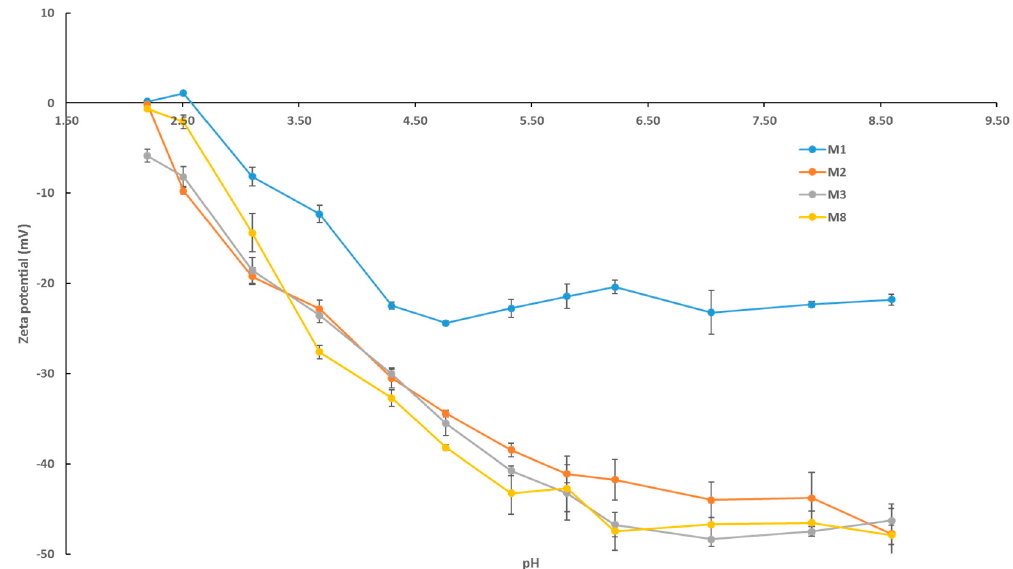
Figure 7 . pH scans for selected fabricated PES membranes displaying zeta potential readings. Each bar represents the mean ± SD of three independent readings.